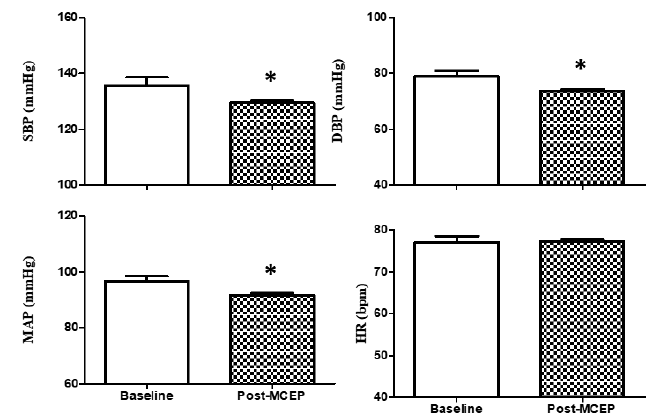
Figure 3. Hemodynamic parameters. Values are mean ± S.D. SBP, systolic blood pressure; DBP, diastolic blood pressure; MAP, mean arterial pressure; HR, heart rate; * p < 0.05 versus baseline.